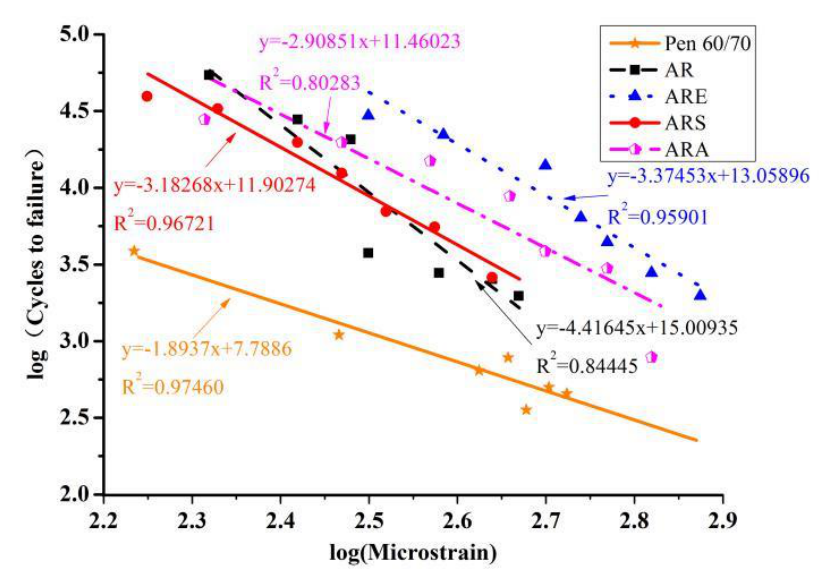
Figure 6. ITFT measurements for mixtures.